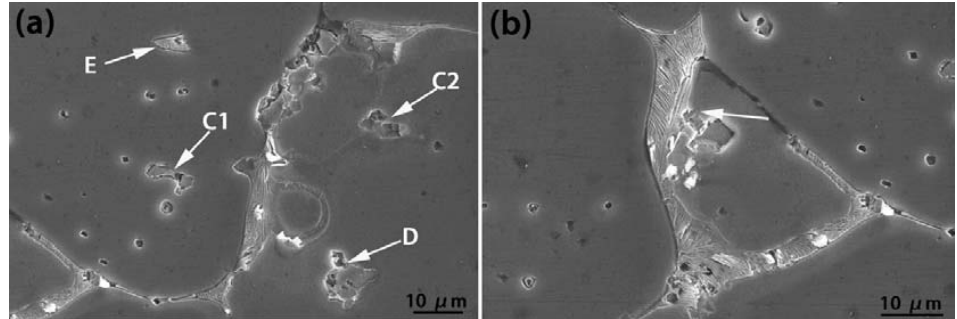
Figure 6. The SEM images of the RAP ‐ processed AA7075 alloy held at 620 °C for 15 min, the process of coarsening ( a ) and migration ( b ) of the intra ‐ granular liquid droplets.